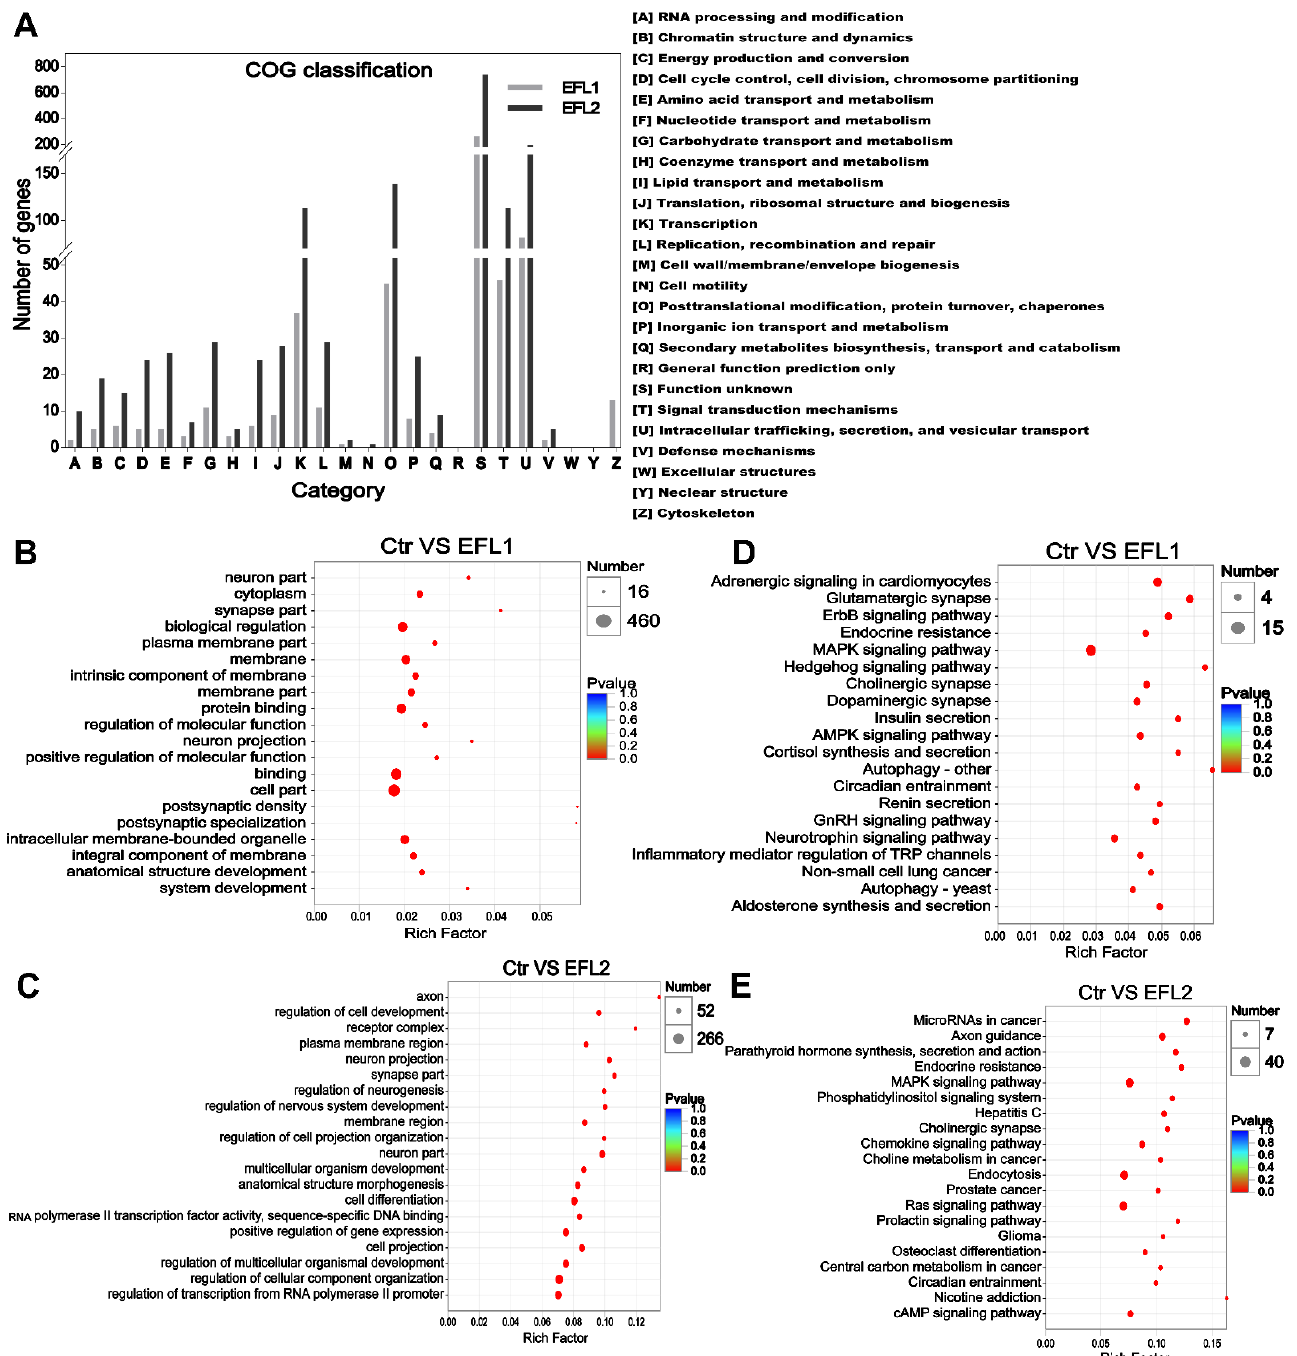
Figure 4. ( A ) The COG classification of differentially expressed miRNA in EFL-treated Caco-2 cells. ( B ) GO and ( C ) KEGG annotation of the differentially expressed miRNA in the EFL1 group. ( D ) GO and ( E ) KEGG annotation of the differentially expressed miRNA in the EFL2 group.